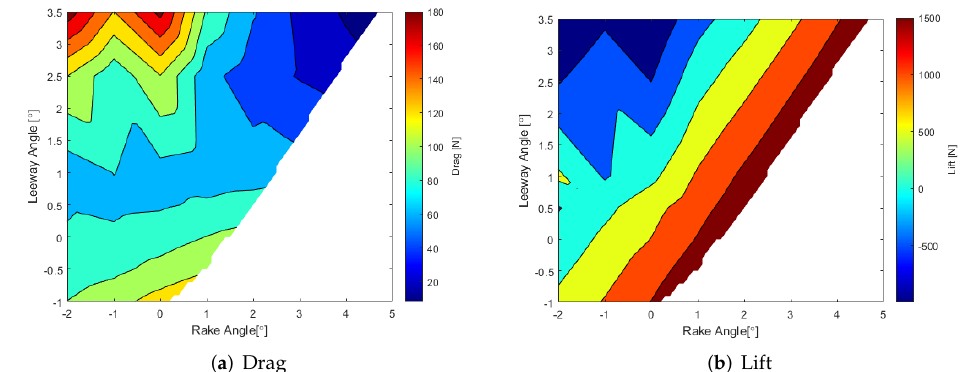
Figure 29. Lift and drag for the investigated range of leeway and rake angles and flow speed of 9 m/s.